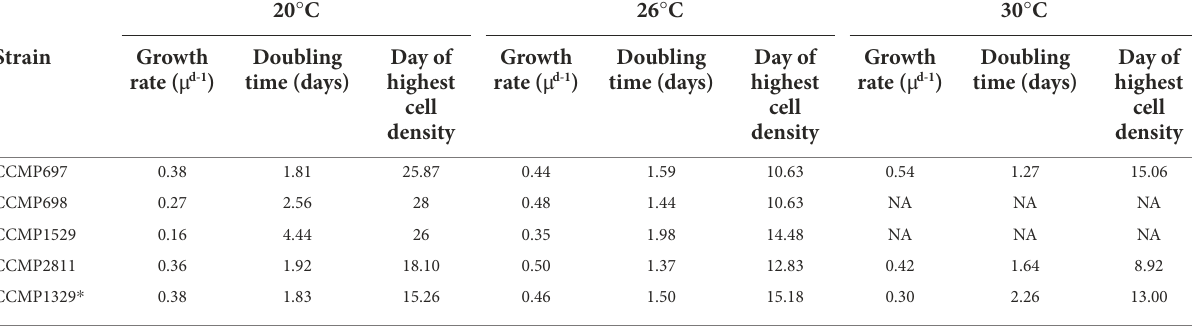
The cell concentrations (cell/ml) determined by flow cytometry for three independent growth curves at each temperature were fitted to a generalized additive model (GAM). Growth parameters were obtained as described in Materials and methods. Supplementary Figure 4 shows calculation of growth rate. * Axenic. NA, strains CCMP1529 and CCMP698 were not able to grow at 30 °